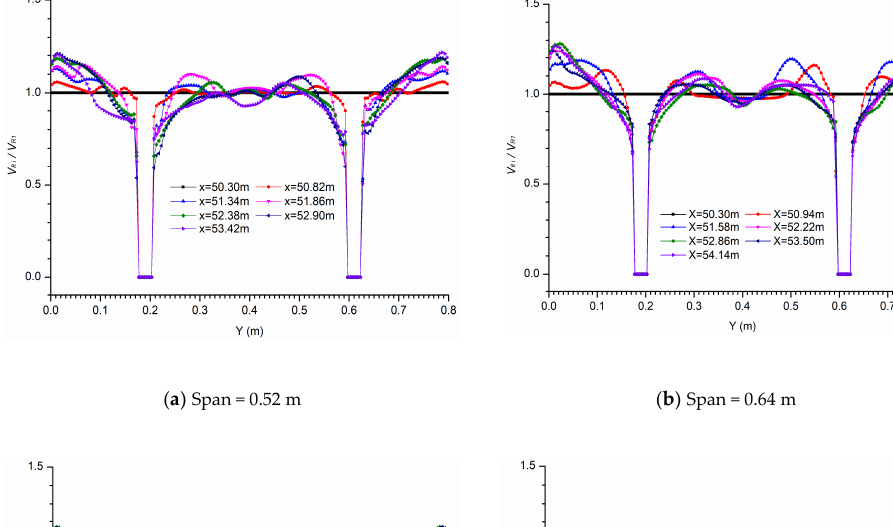
Figure 11. Fluids 2020 , 5 , x FOR PEER REVIEW